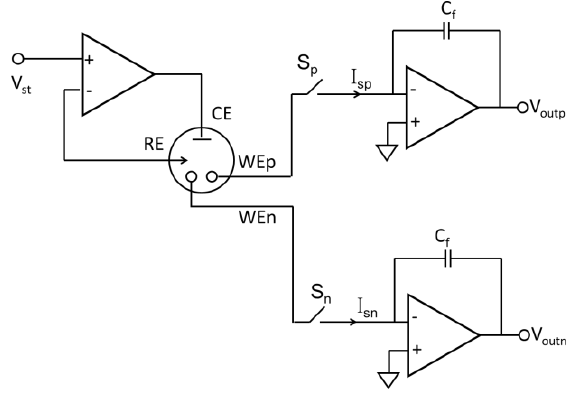
Figure 10. The structure of the pseudo-differential amperometry readout circuit (adapted from [41]).